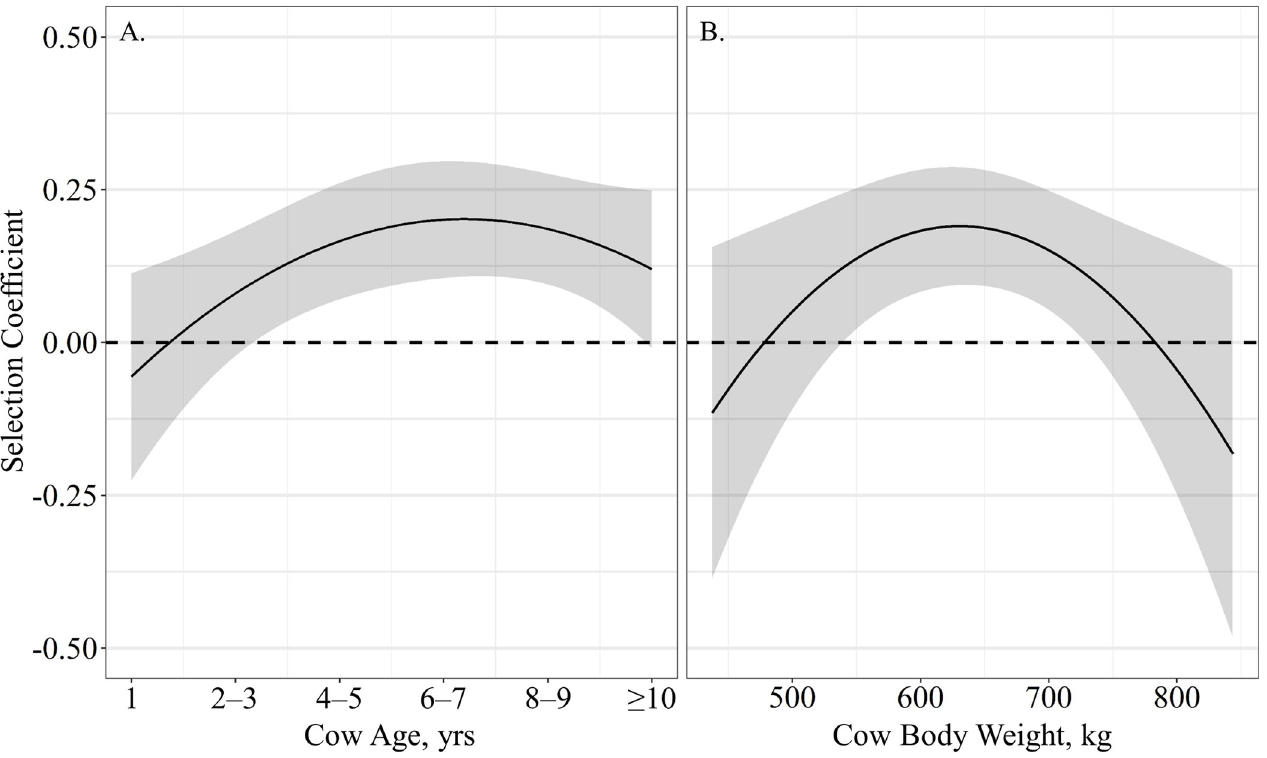
Fig 5. Predicted relationships ( ± 95%CI represented in the shaded area) between ( A ) cow age (years) and ( B ) cow body weight (kg) on resource utilization relative to distance from water by cattle grazing dormant northern mixed grass rangeland in 2016 – 2017 & 2017 – 2018 at the Northern Agricultural Research Center Thackeray ranch, Havre,